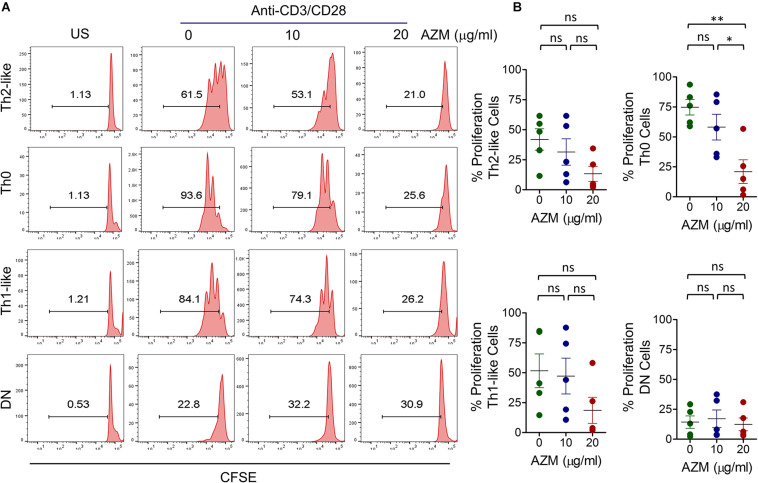
AZM suppresses helper T cell subset proliferation. CFSE-labeled CD4+ T cells were stimulated with anti-CD3 and anti-CD28 in presence of indicated concentration of AZM for 3 days. Cells without anti-CD3 and CD28 activation (US) were taken as control. Individual Th subsets (Supplementary Figure S1B) were gated to determine cell proliferation by flow cytometer. (A) Numbers in representative FACS histograms show percent proliferation based on CFSE dilution. (B) Aligned dot plots show mean ± SEM of CFSE dilution by different Th subsets. Data presented are from five independent experiments performed on healthy individuals (n = 5). *P < 0.05, **P < 0.01, ns stands for non-significant.